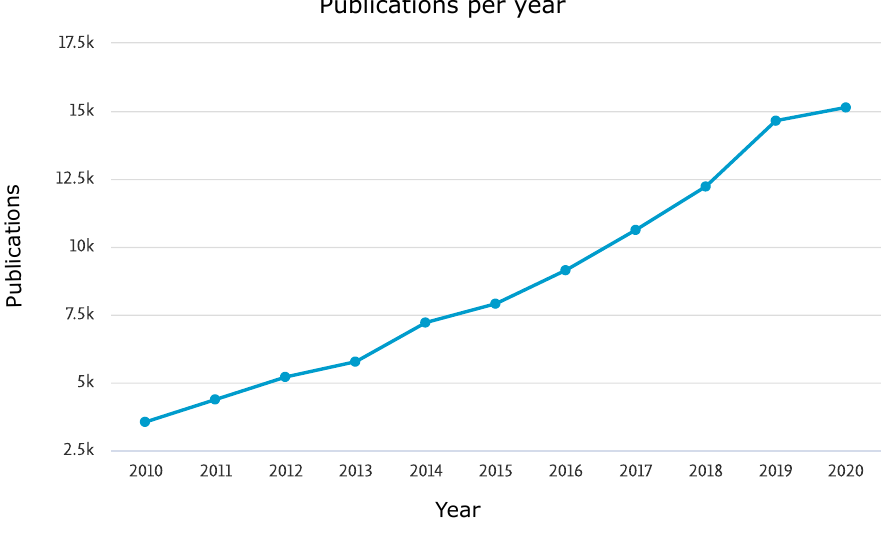
Figure 1. Scopus analysis on energy storage systems researches in the last 20